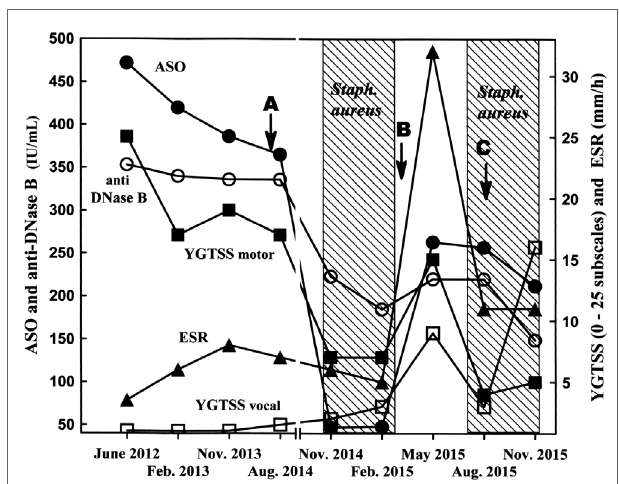
FIGURe 1 | Clinical and laboratory records . Arrows indicate the times of blood sampling for autoimmunity testing. ASO, anti-streptolysin O antibody (filled circles); anti-DNase B, anti-deoxyribonuclease B antibody (open circles); ESR, erythrocyte sedimentation rate (filled triangles); YGTSS motor, Yale global tic severity score motor subscale (filled squares); YGTSS vocal, Yale global tic severity score vocal subscale (open